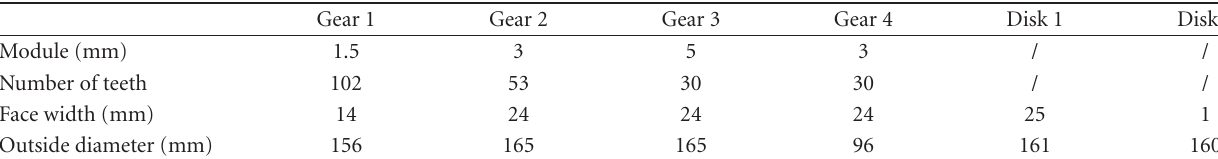
Table 1: Gear and disk data.